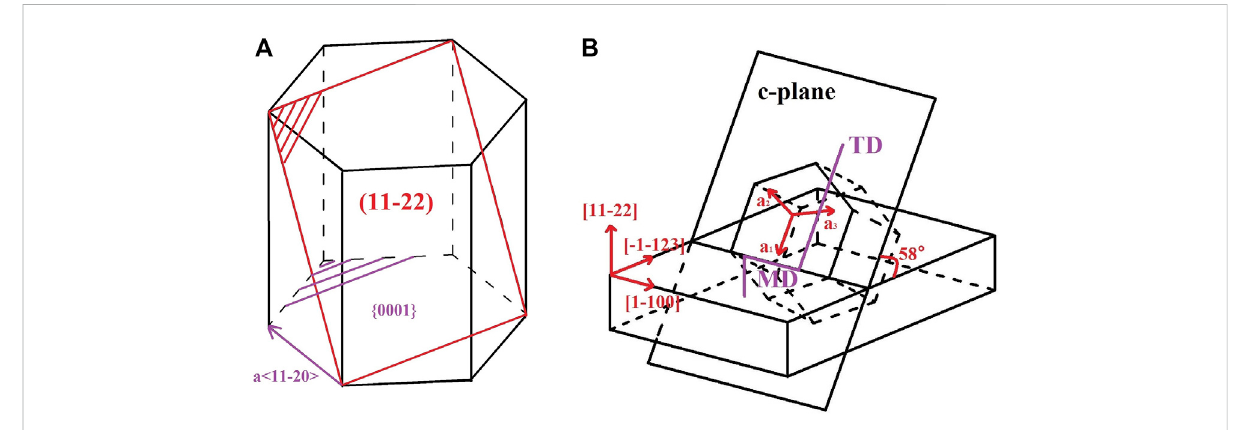
FIGURE 6 Schematic of mis fi t dislocation con fi guration in semi-polar (11-22) AlN fi lms. (A) is cubic chart; (B) is cross-section